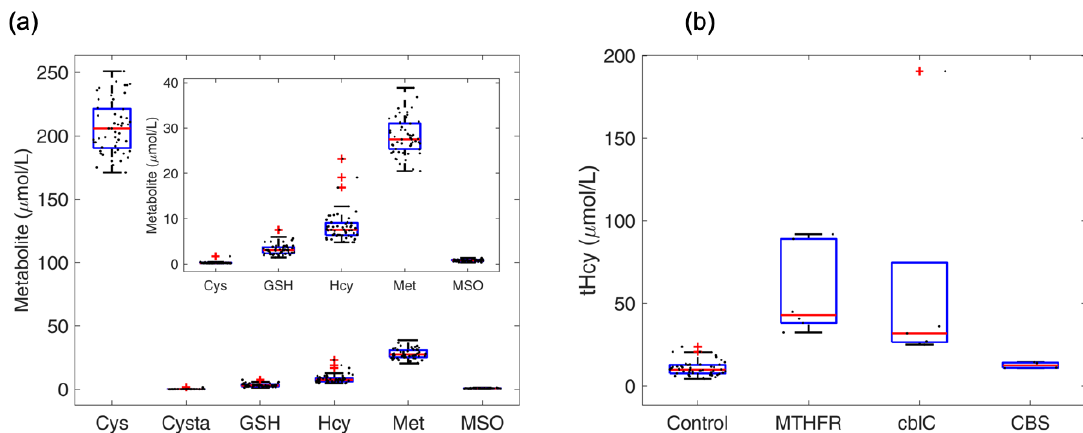
Figure 3. Analysis of thiol and thioether metabolites in untreated human plasma as typically processed in clinical diagnostic laboratories. Panel ( a ). Plasma metabolites in a cohort of healthy individuals (18–59 years old, N = 53). Panel ( b ). Plasma homocysteine in healthy subjects and in patients with homocystinuria due to deficiencies in methylenetetrahydrofolate reductase, cblC and cystathionine β -synthase (MTHFR, cblC, CBS). The patient with CBS deficiency was responsive to treatment with vitamin B6, which a ff orded excellent biochemical control of plasma Hcy concentration to the range observed in healthy subjects (5–15 µ M). Center mark (red) represents the median, and bottom and top edges of the box represent the 25th and 75th percentiles, respectively. The whiskers extend to the most extreme data points, and points considered outliers are marked with the ‘ + ’ symbol. The outliers in the disease groups typically represent patients with a severe phenotype, or else patients with poor compliance with or no response to treatment.